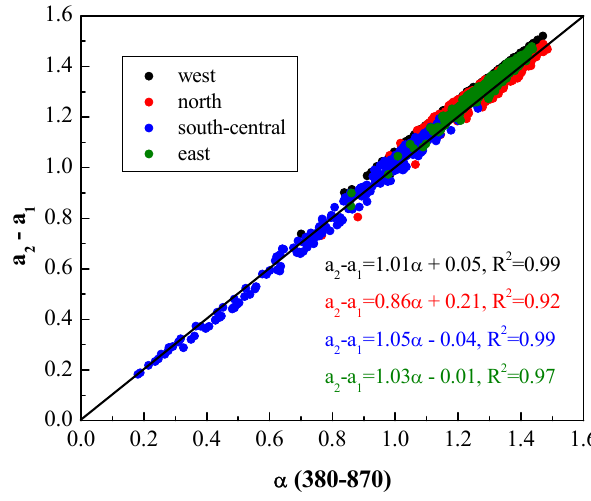
Fig. 4. Correlation between α 380 − 870 and a 2 – a 1 in the 4 BoB sub- regions. The linear relations for each region are shown in separate